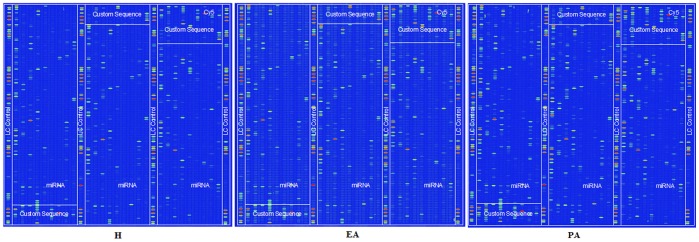
miRNA expression profile during porcine follicular atresia.Healthy (H), early atretic (EA), progressively atretic (PA) are representative regions of the Cy5 chip images. The images are displayed in pseudo-colors to expand the visual dynamic range. As the signal intensity increased from 1 to 65,535, the corresponding color changed from blue to green to yellow and red.